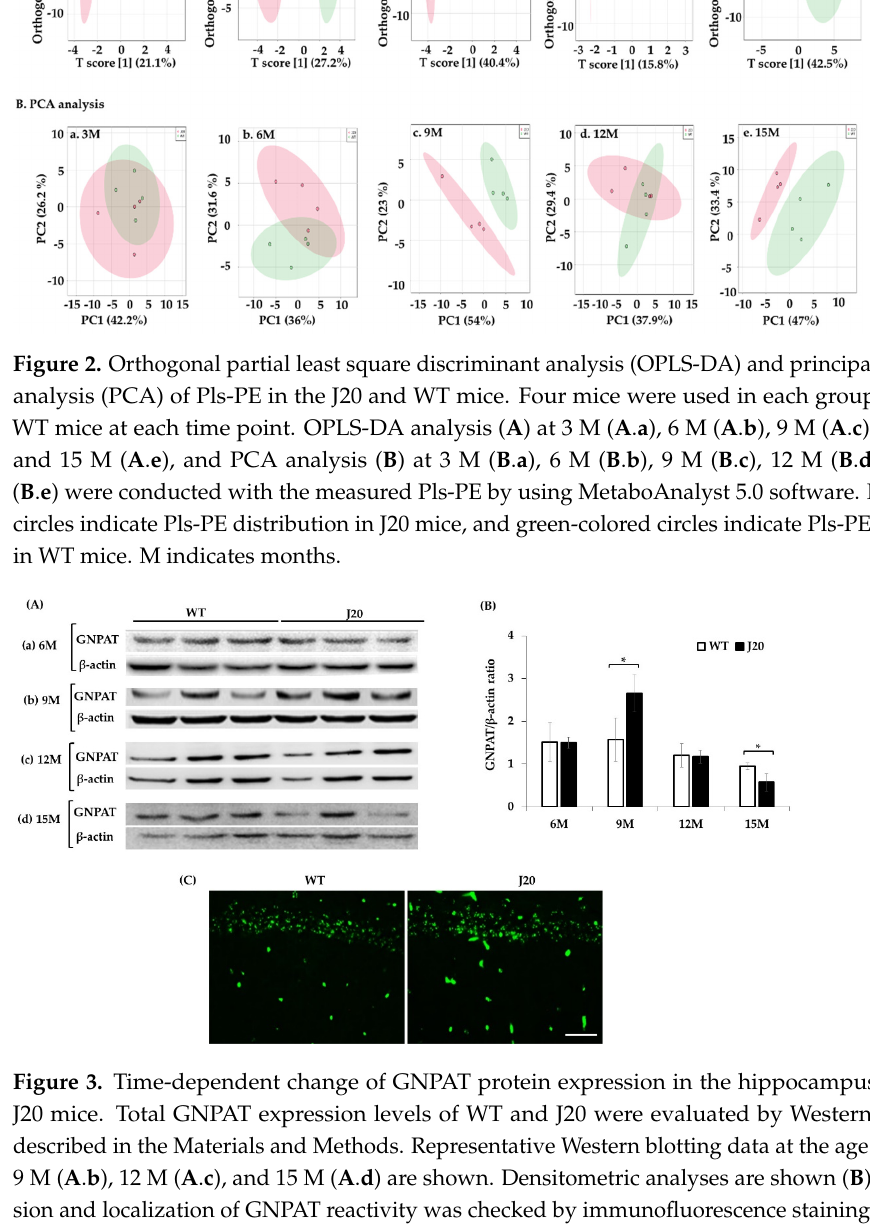
Figure 4. Localization of GNPAT with glial cells in J20 mice, and change of neuronal and glial cell at 9 months in J20 and WT mice. Double immunofluorescence staining of GNPAT with Iba1 and GFAP was performed, as described in the Ma- terials and Methods. Representative immunophotomicrographs are shown ( A ). The change of neuronal and glial cells in